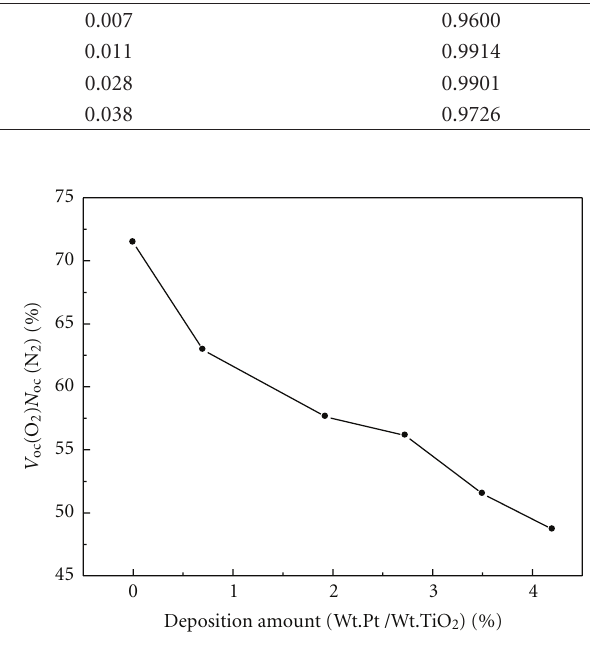
Figure 6: Dependence of [ V oc (O 2 )/ V oc (N 2 )] on deposited Pt